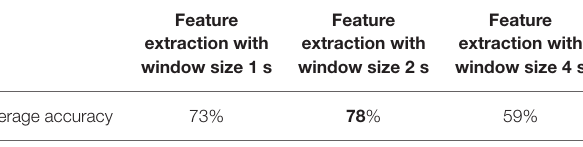
During the 20-min stimulation period, rTMS was delivered at a 100% resting-motor threshold (Hermiller et al., 2019). The rTMS procedure was 20 Hz for 2 s of stimulation duration (totaling 1,640 pulses each session), followed by a 28-sinterstimulus period (Wang et al., 2014).